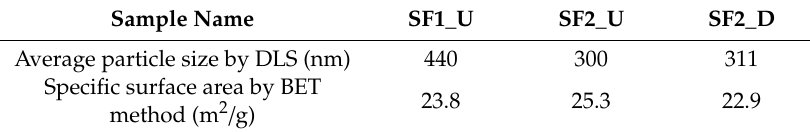
Figure 6. Particle size distribution of SF samples by DLS and SEM-based image processing techniques. Table 3. Average particle size and specific surface area of SF